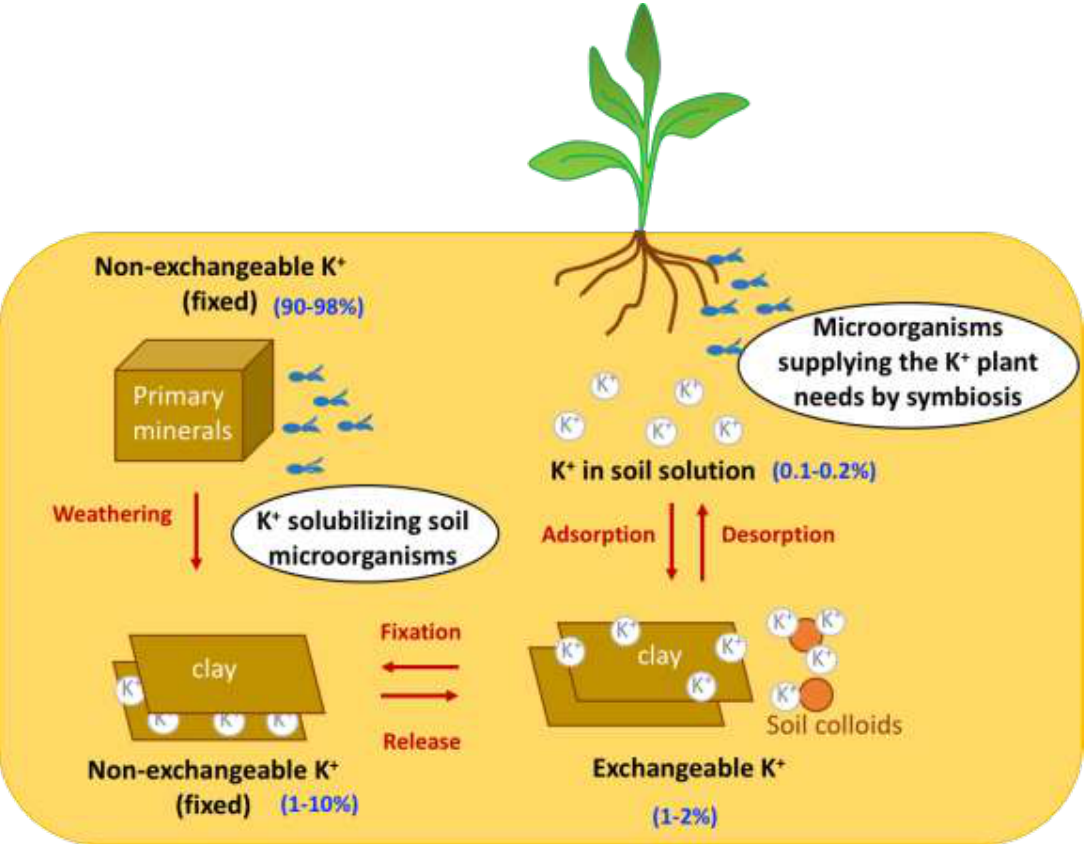
Figure 1. Role of microorganisms living in the soil in the dynamics of the K + cycle. Scheme depicting the microbial strategies to improve K + plant nutrition: K + solubilizing microorganisms and microorganisms establishing symbiotic associations with plants.